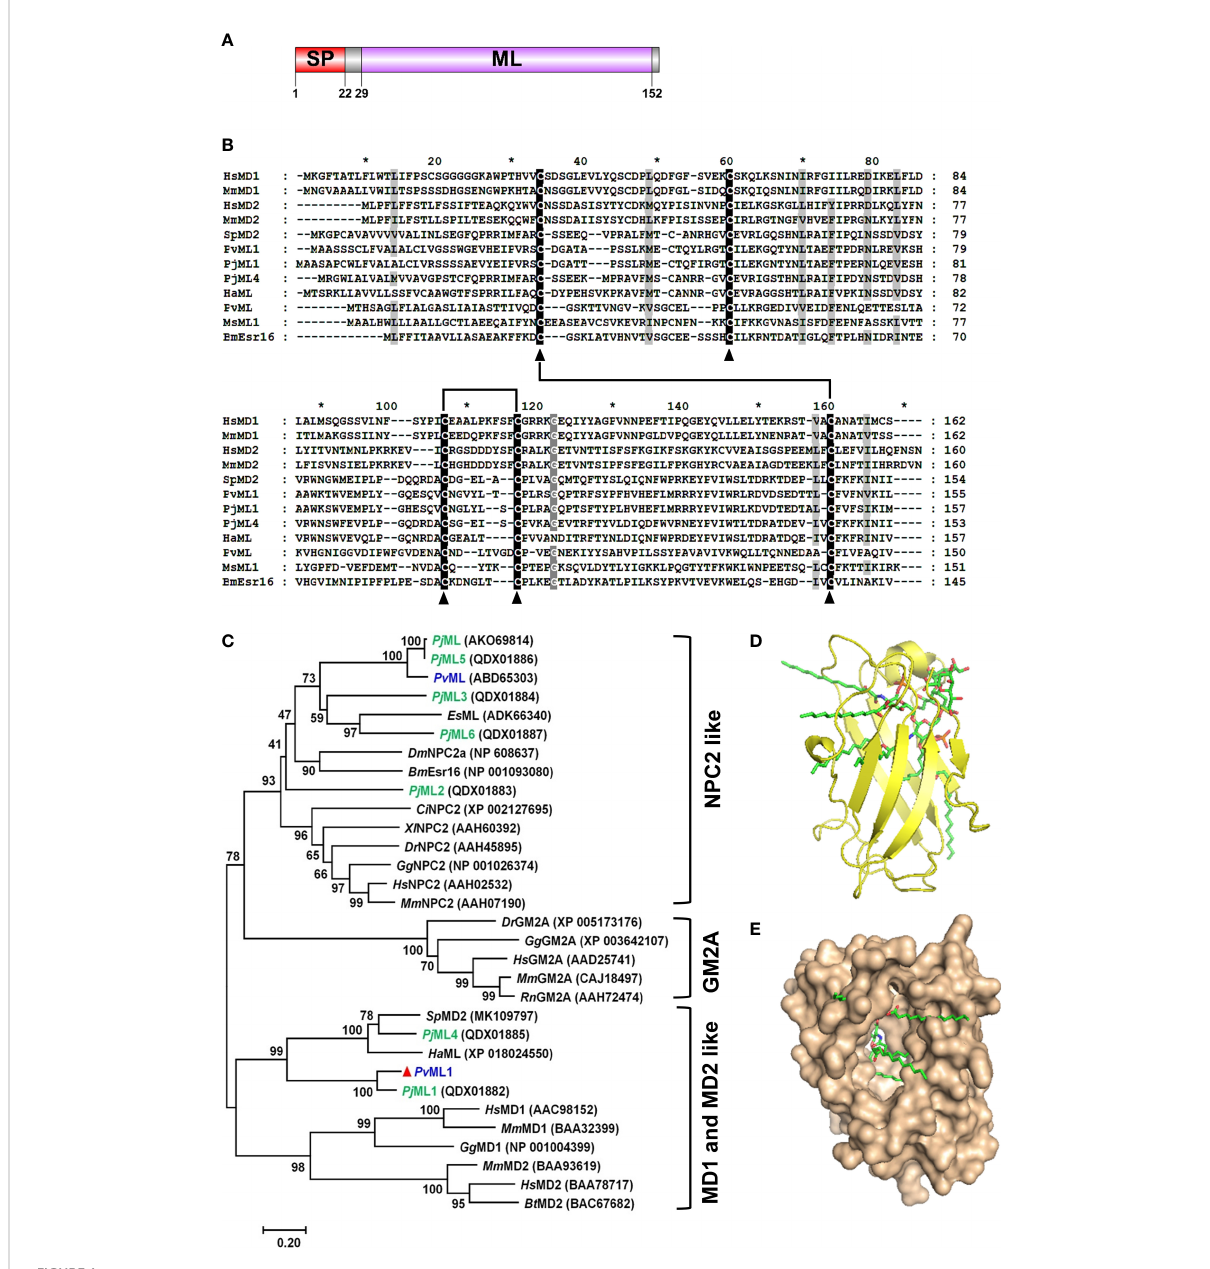
FIGURE 1 Sequence and architecture information of Pv ML1. (A) Schematic of Pv ML1 domains was predicted with SMART software. (B) Multiple alignment of Pv ML1 with other representative ML domain-containing proteins. Hs , Homo sapiens ; Mm , Mus musculus ; Sp , Scylla paramamosain ; Pv , Penaeus vannamei ; Pj , Penaeus japonicus ; Ha, Hyalella azteca ; Ms, Manduca sexta ; Bm, Bombyx mori . (C) Phylogenetic analysis of Pv ML1 and other retrieved ML domain-containing proteins by MEGA 7.0. Bootstrap values were showed at each node, and Pv ML1 was marked with red triangle. ML protein family from P . japonicus was highlighted in green. ML protein of P . vannamei were highlighted in blue. The corresponding GenBank accession numbers and names were listed. Es , Eriocheir sinensis ; Dm , Drosophila melanogaster ; Ci , Ciona intestinalis , Dr , Danio rerio ; Gg , Gallus gallus ; Rn, Rattus norvegicus . The predicted 3D model of Pv ML1-Lipid A complex. The Pv ML1-Lipid A complex with a docking score of 5.981 was shown in two different manners (observe from the side (D) or from the opening of the protein ‘ cavity ’ (E) ). The ligand lipid A was displayed in